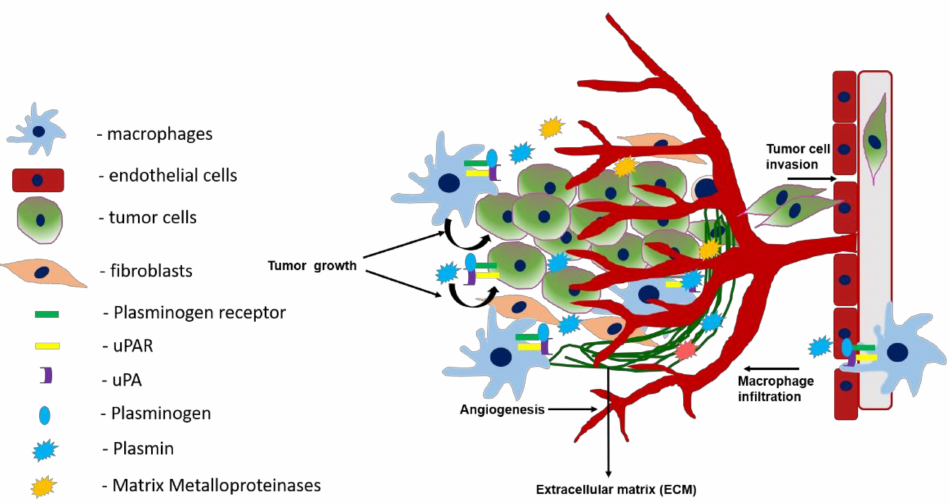
Figure 3. Role of the plasminogen activation system in tumor growth, angiogenesis, macrophage infiltration, and invasion. Activation of plasminogen bound to plasminogen receptors at the cell surface of macrophages and tumor cells is mediated by uPA bound to uPAR. This results in the production of plasmin which activates matrix metalloproteinases and together these proteases play a key role in the infiltration of macrophages to tumor sites. At the tumor site, macrophages promote tumor growth, angiogenesis, and metastasis. Plasmin produced by the tumor cells mediates tumor cell migration and invasion both by protease dependent and independent